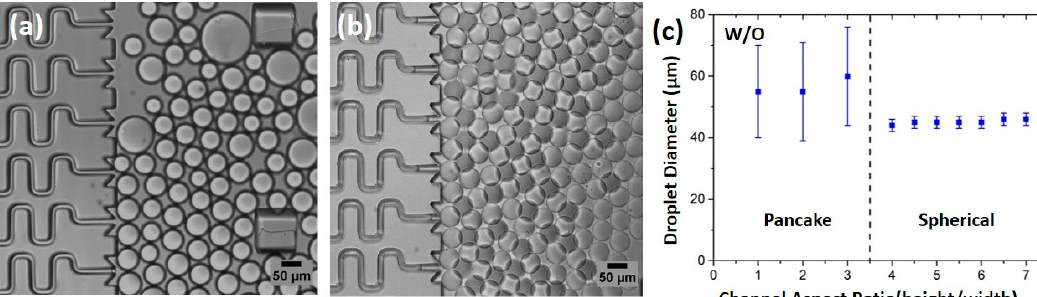
Figure 2. The experimental results of the water-in-oil (W/O) droplets generated from channels with different aspect ratios. ( a ) A micrograph showing polydisperse droplets generated from channels with an aspect ratio of 2. Some big droplets are pancake shaped. ( b ) A micrograph showing uniform droplets generated from channels with an aspect ratio of 4. ( c ) Droplet diameter versus the channel aspect ratio (height/ width). Droplets have a spherical shape and monodisperse with coefficient of variation (CV) <3% for channel aspect ratios 4 and above. The droplet diameter is about 3.5 times the channel width and is not affected by the channel depth. The flow rate of the dispered phase is 1 mL/h and the oil phase is static.